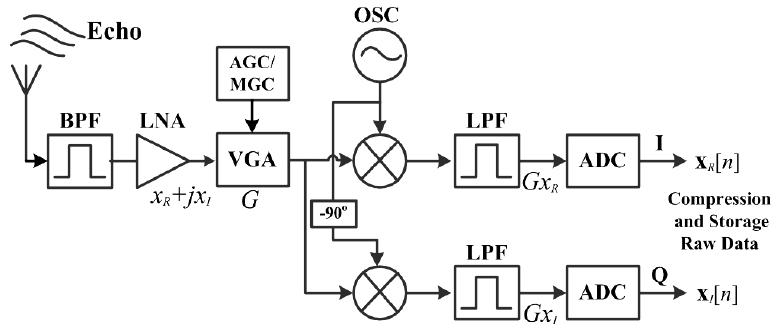
Figure 2. Simple diagram of a radar receiver. BPF stands for Berkeley Packet Filter. LNA stands for Low-Noise Amplifier. AGC stands for Automatic Gain Controller. MGC stands for Manual Gain Controller. VGA stands for Variable Gain Amplifier. OSC stands for Open Source Commerce. LPF stands for Low-Pass Filter.